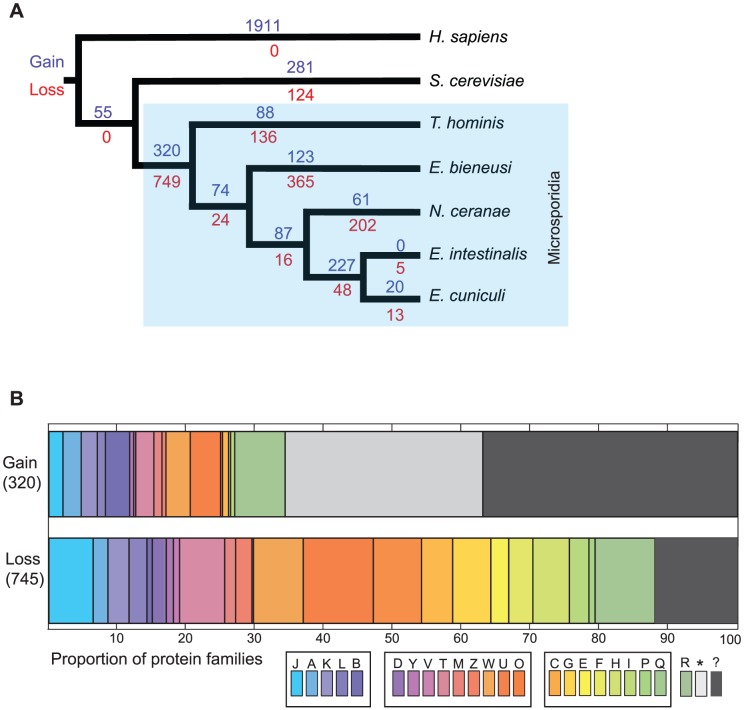
Gain and loss of protein families during microsporidian genome evolution.Homologous protein families were identified using MCL clustering of similar sequences, as determined by PHMMER searches (E<0.01). To prevent the clustering of otherwise unrelated proteins that share a common functional domain, we required that significantly similar sequence pairs align over at least 50% of their length. (A) Gain and loss events inferred using Dollo parsimony were mapped onto a cladogram derived from an 18S rRNA phylogeny [16]. The numbers on the cladogram show the number of protein families lost (red) or gained (blue). (B) Functional classification of protein families gained or lost in the microsporidian ancestor using the COG functional categories, with the three broad divisions of informational genes, cellular processes and metabolism delineated. The microsporidian losses are distributed across COG categories, with a particular impact on cellular processes and metabolism, whereas most of the gains are of unknown function. Key: J, translation, ribosomal structure and biogenesis; A, RNA processing and modification; K, transcription; L, replication, recombination and repair; B, chromatin structure and dynamics; D, cell cycle control, cell division, chromosomal partitioning; Y, nuclear structure; V, defence mechanisms; T, signal transduction; M, cell wall/membrane/envelope biosynthesis; N, cell motility; Z, cytoskeleton; W, extracellular structures; U, intracellular trafficking, secretion, vesicular transport; O, posttranslational modification, protein turnover, chaperones; C, energy production and conversion; transport and metabolism of: G, carbohydrate; E, amino acids; F, nucleotides; H, coenzymes; I, lipids; P, inorganic ions; Q, secondary metabolites. R – general function prediction only; *, no whole-protein functional assignment, but contains a known functional region identified by HHsearch [44] (Table S8); ?, no functional region identified using HHsearch.